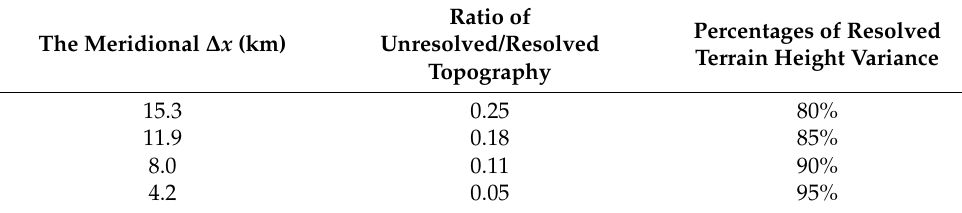
The Meridional ∆ x